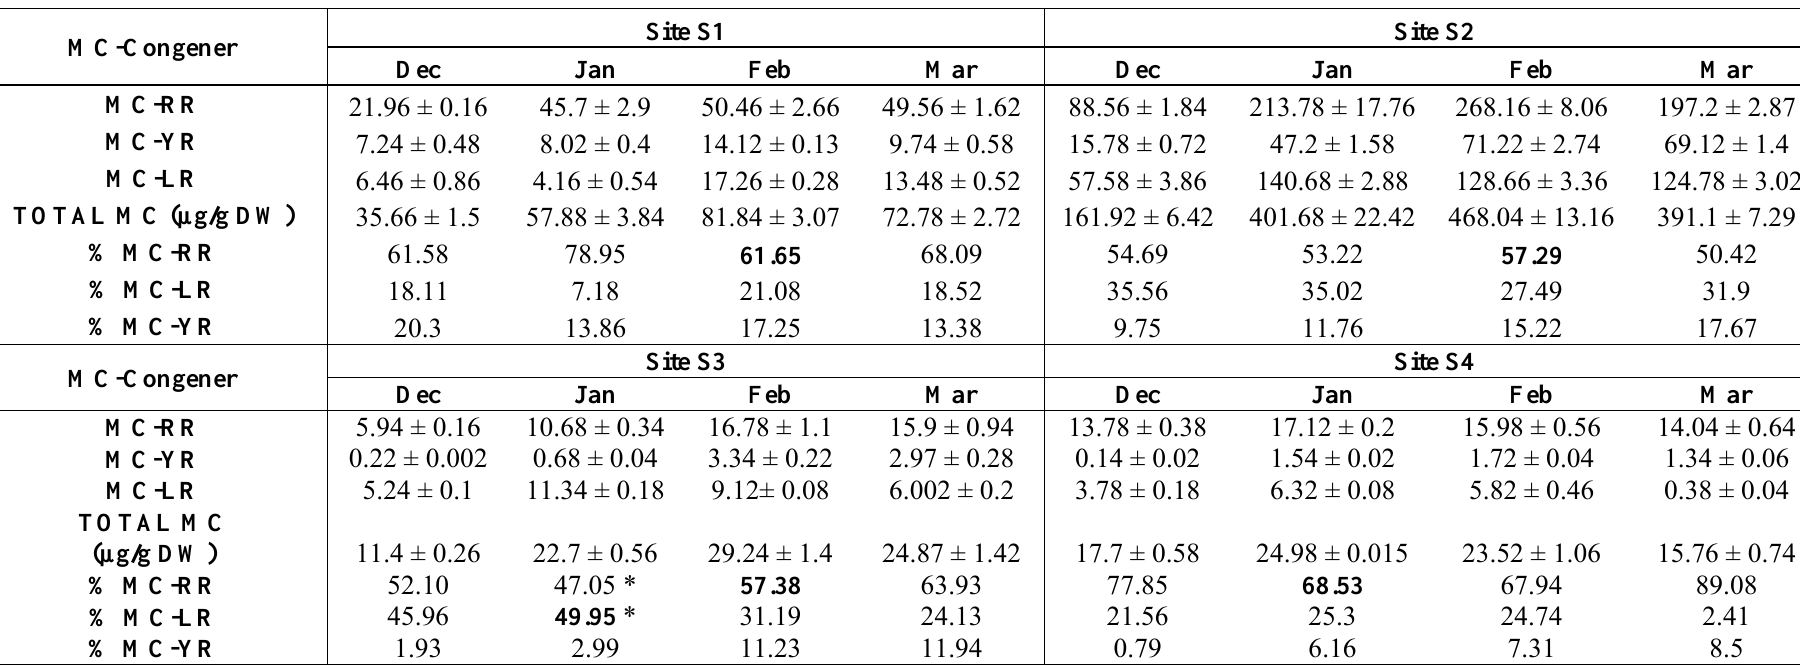
Table 2. Site-specific monthly concentrations of each MC-congener, total MC concentrations (quantified MCs only) and content (%) of each congener (each concentration is a mean value of n = 3, ±